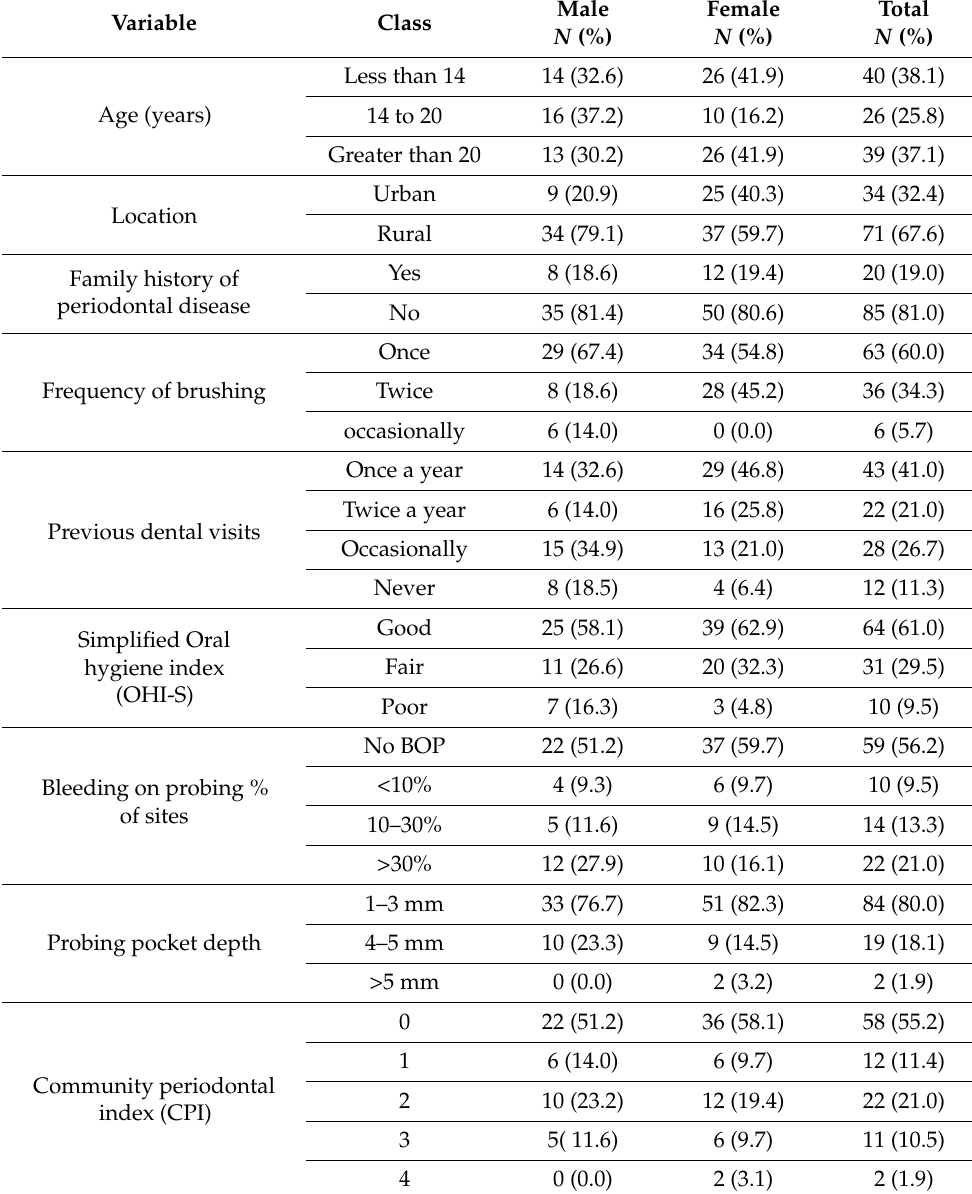
Table 1. Frequency and percentage distribution of patients based on gender according to various study